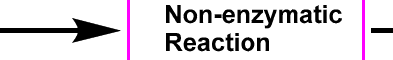
Figure 16. Catalysed reactions by Xanthine Oxidase.